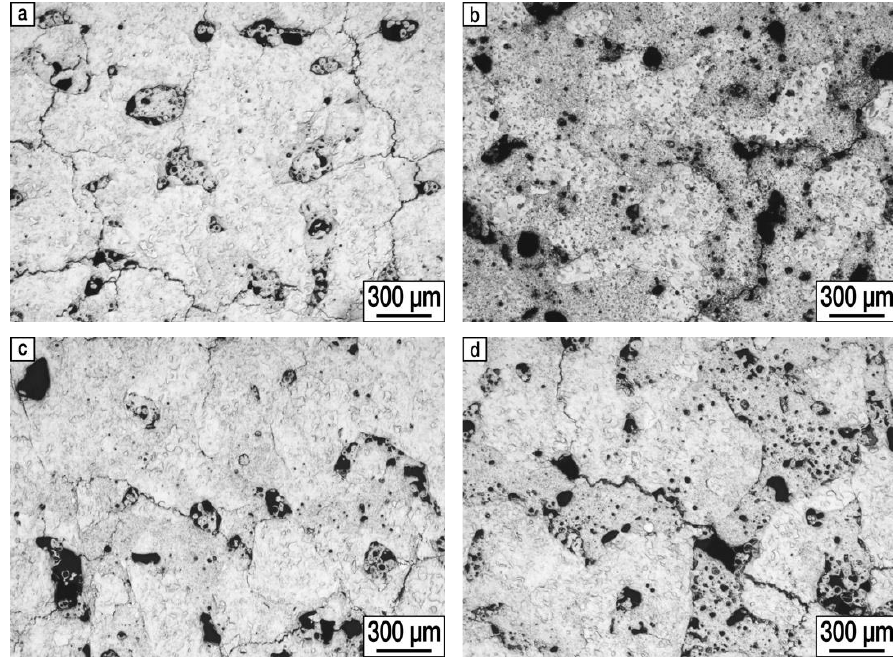
Figure 12. Images of the W-5Ni-2Fe SLM samples structure produced at different laser power: 600 W ( a ); 700 W ( b ); 800 W ( c ); 900 W ( d ) under laser scanning velocity of 500 mm/s.